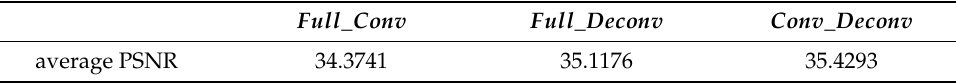
Figure 11. CDF of PSNR for network structure implemented with convolution or deconvolution on 1886 random selected images. Table 5. PSNR of conv/deconv on 1886 random selected